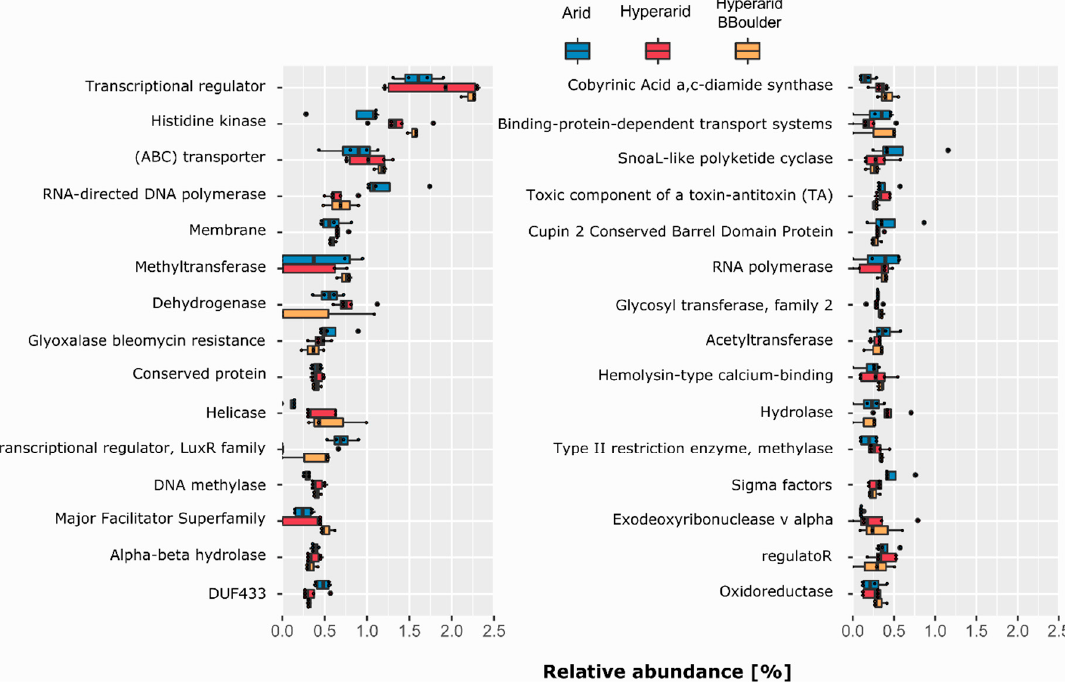
Figure 5. The most abundant COG protein name / description co-occurring with MGEs. COGs with the same protein name / description were merged. n = 4, 5 and 3 at the Arid, Hyperarid and Hyperarid-BBoulder sites, respectively. The 30 most abundant protein names / descriptions are shown.